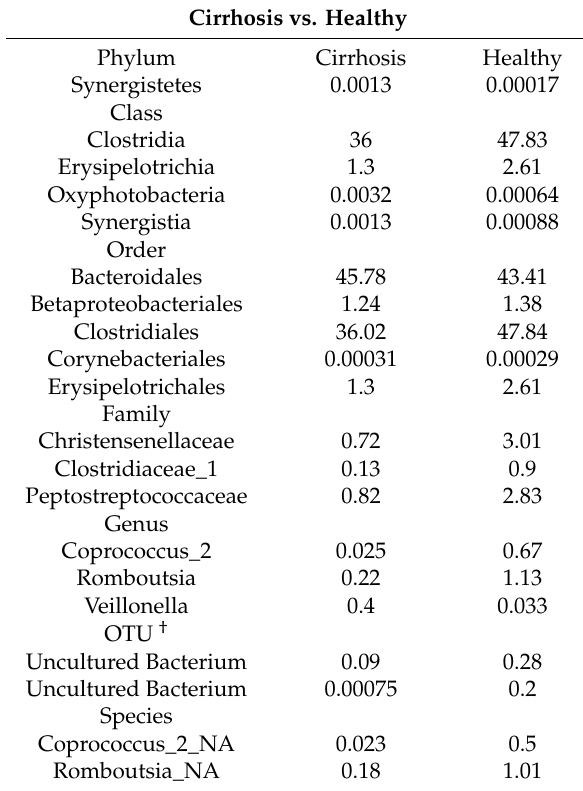
Table 7. Taxonomic di ff erences found with analysis of composition of microbiomes between cirrhosis and healthy groups on all taxonomic levels.